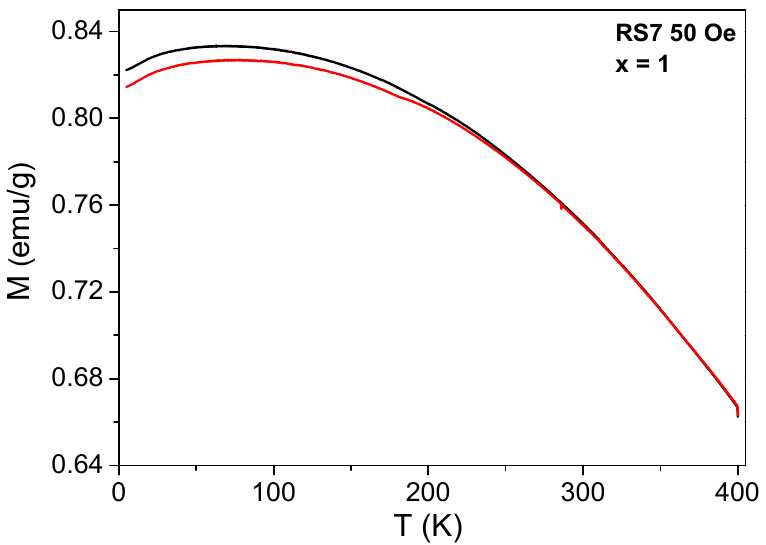
Figure 9. ZFC and WFC M(T) curves recorded for a probe field of 50 Oe for the RS7 sample. Black line indicates WFC and red line ZFC, respectively.